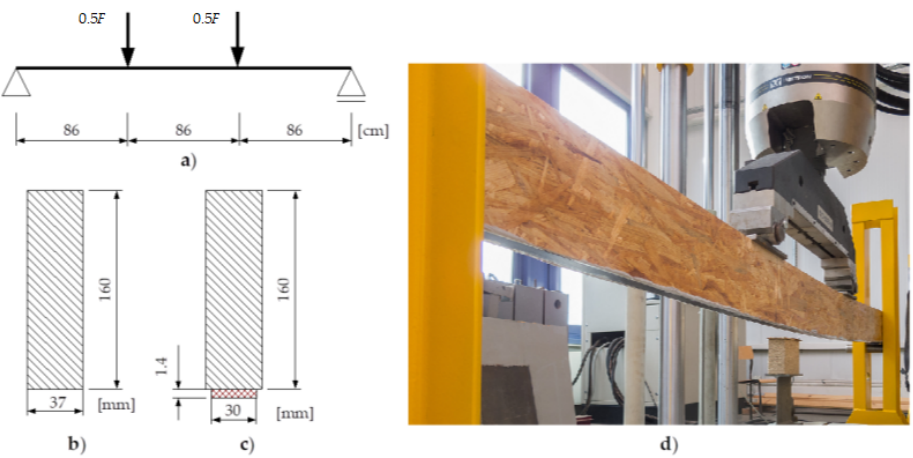
Figure 1. Static scheme and cross-sections of beams: ( a ) static scheme, ( b ) cross-section of OSB beam, ( c ) cross-section of OSB beam reinforced in the tensile zone with CFRP strip, ( d ) one of the beams during testing.